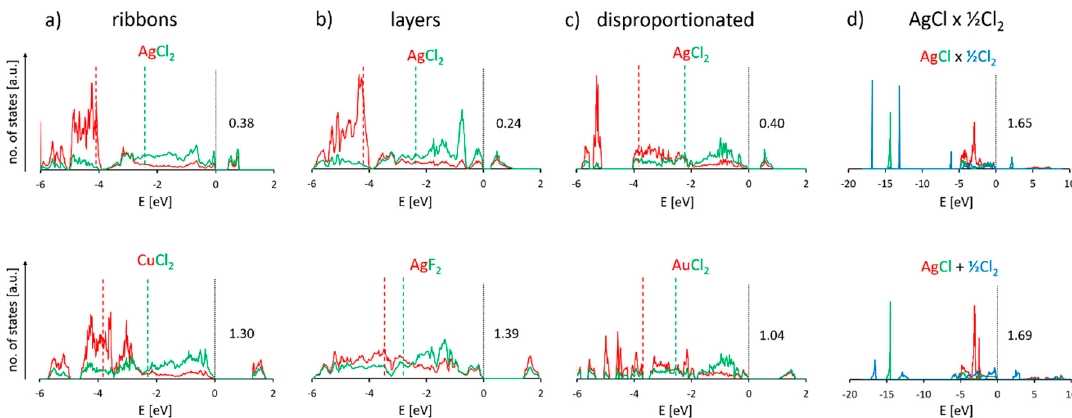
Figure 10. Comparison of the electronic density of states (DOS) graphs of four studied structures of AgCl 2 and their counterparts: ( a ) ribbon structure and CuCl 2 , ( b ) layered structure and AgF 2 , ( c ) disproportionated structure and AuCl 2 , ( d ) Ag(I)[Cl(Cl 2 ) ½ ] form with hexagonal AgCl layers and the sum of eDOS of rocksalt AgCl and solid Cl 2 . Red and green dashed lines indicate the DOS-weighted average position of Cu / Ag / Au d and Cl / F p bands, respectively. The number above Fermi level in each graph indicates the fundamental band gap.